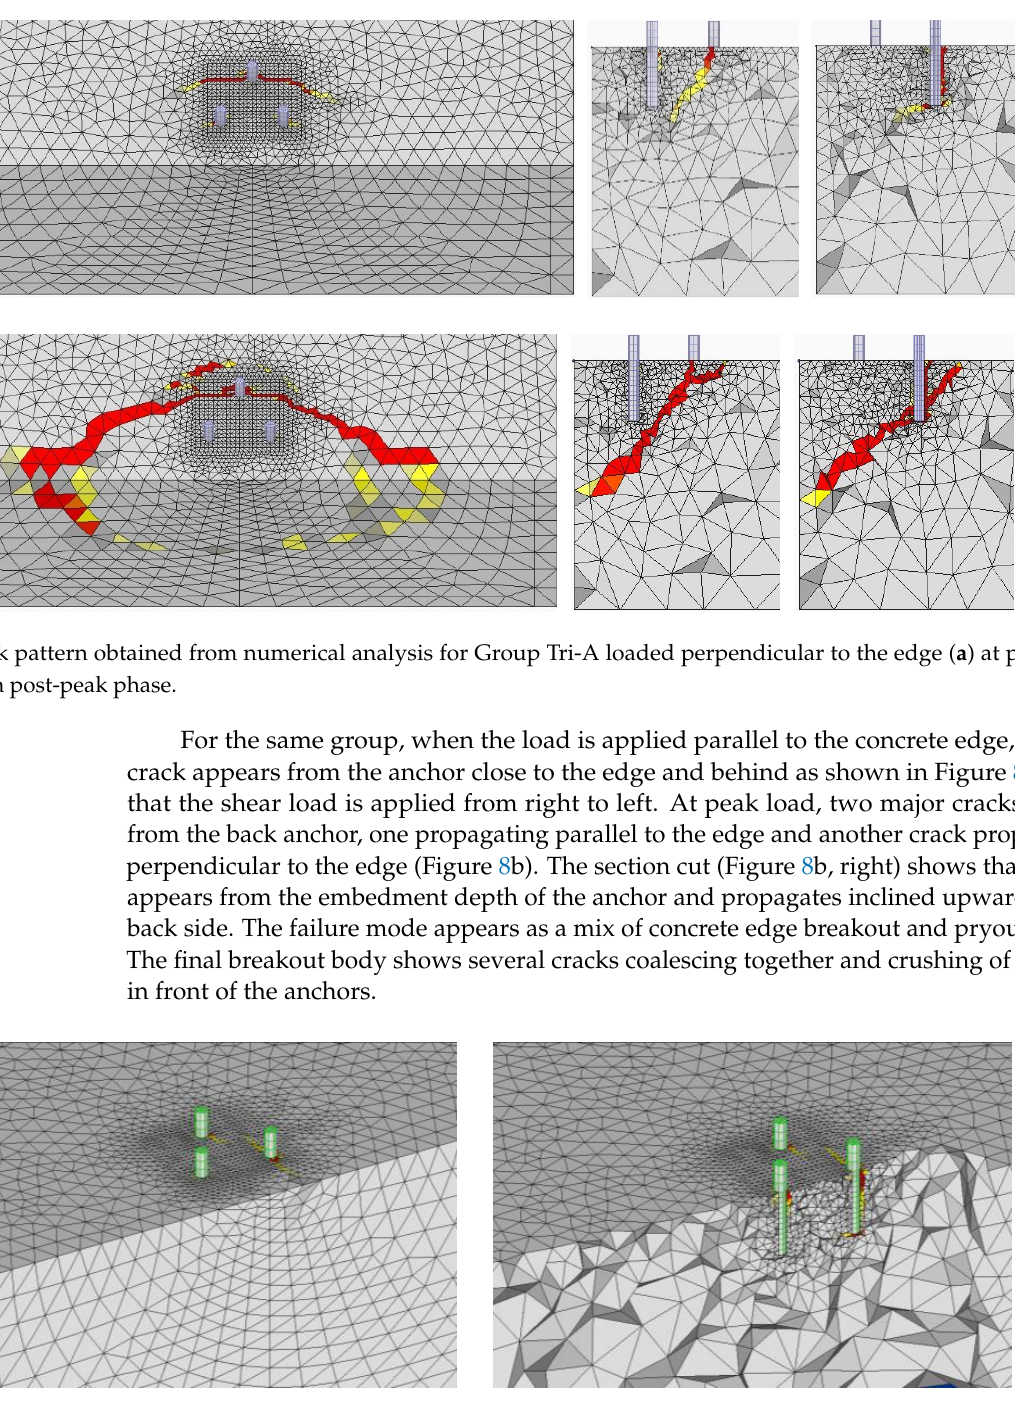
(c) Figure 8. Crack pattern obtained from numerical analysis for Group Tri-A loaded parallel to the edge ( a ) first cracks, ( b ) at peak load, and ( c ) post-peak phase. 3.1.2. Group Tri-B Group Tri-B was a mirror image of the Group Tri-A with one anchor in the front and two anchors in the back row. Group Tri-B displayed same initial stiffness as for Group Tri-A due to the same number of anchors in the group. This is understandable since the shear stiffness of the anchors in normal concrete is considered fairly independent of the edge distance provided that all other installation parameters are the same [9,13,14,29]. However, due to different orientation of the anchors, this group reached a higher failure load. The load-displacement curve given in Figure 6 shows that both the groups display a similar load-displacement response qualitatively. For the group Tri-B loaded perpendic- ular to the edge, the failure load was 107.9 kN, which is approximately 11% higher than the value obtained for Group Tri-A when loaded perpendicular to the edge. This differ- ence can be explained by the fact that in series GS-Tri-B, the back anchor row can activate more concrete due to the presence of two anchors. The crack pattern obtained from the numerical analysis is depicted in Figure 9. We can see that the failure crack developed from the back anchor row, and there is only a small concrete crushing visible at the front anchor. In addition, a vertical crack has developed from the front anchor in the post-peak, and a secondary crack is visible behind the back anchor in the post-peak phase.